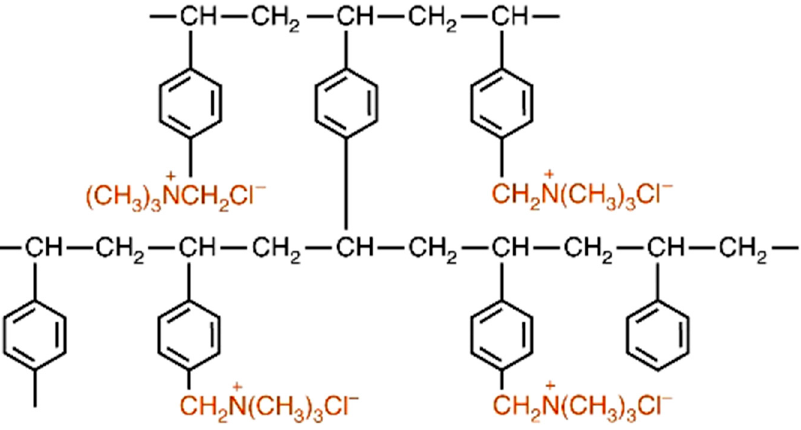
Figure 5. Structure of anion exchanger of type 1.